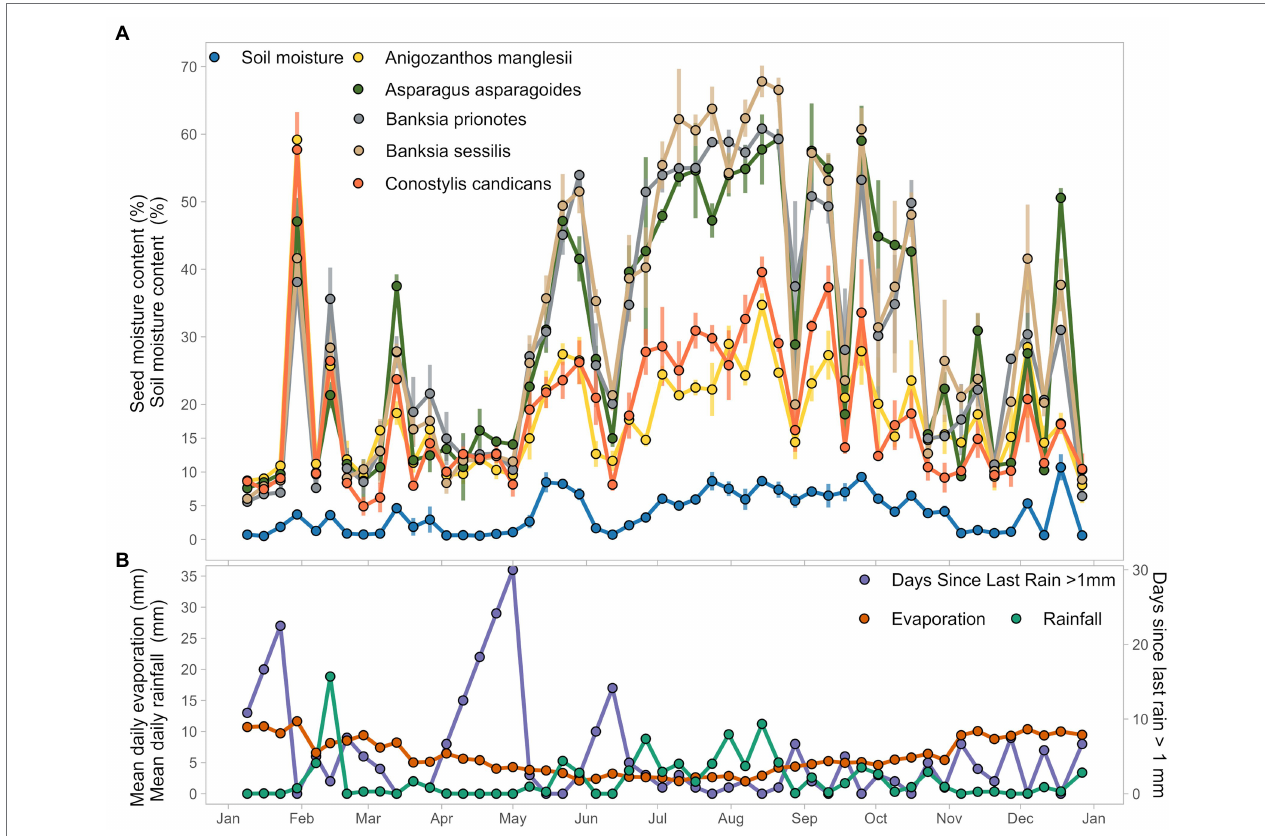
FIGURE 2 | Seed and weather data visualized. Seeds were collected weekly for 51 weeks for the year of 2017. (A) Plotted mean seed moisture content, averaged from three replicates for each collection date, and mean soil moisture content averaged from three replicate samples each collection date. (B) Mean daily pan evaporation and mean daily rainfall for the 7 days preceeding the seed collection date, and number of days since last rain (>1 mm of rain) over the course of 2017. All weather data extracted from Bureau of Meteorology taken from Perth metro weather station and derived products (Bureau of Meteorology, 2020).